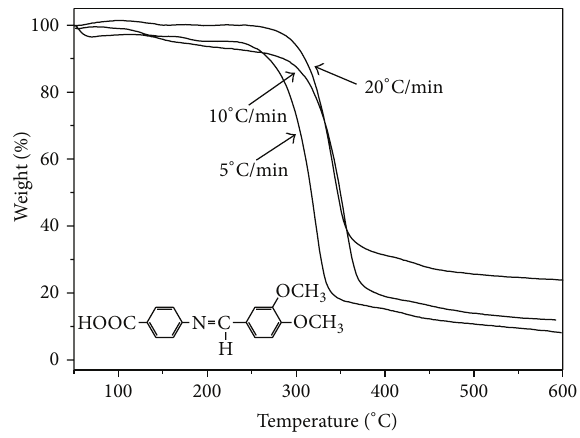
Figure 3: TGA of SBDA with different heating